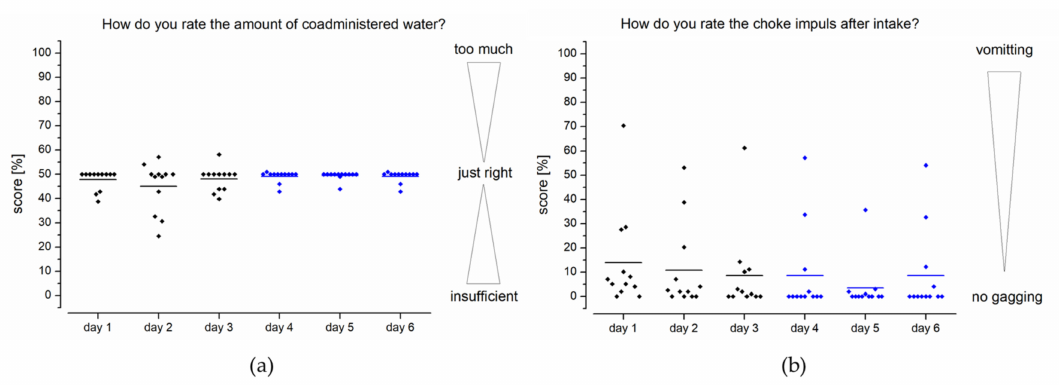
Figure 5. Questionnaire feedback by healthy volunteers ( n = 12) on the volume of water offered ( a ) and choke impulse after application of the device ( b ). Study setup A: days 1–3; study setup B: days